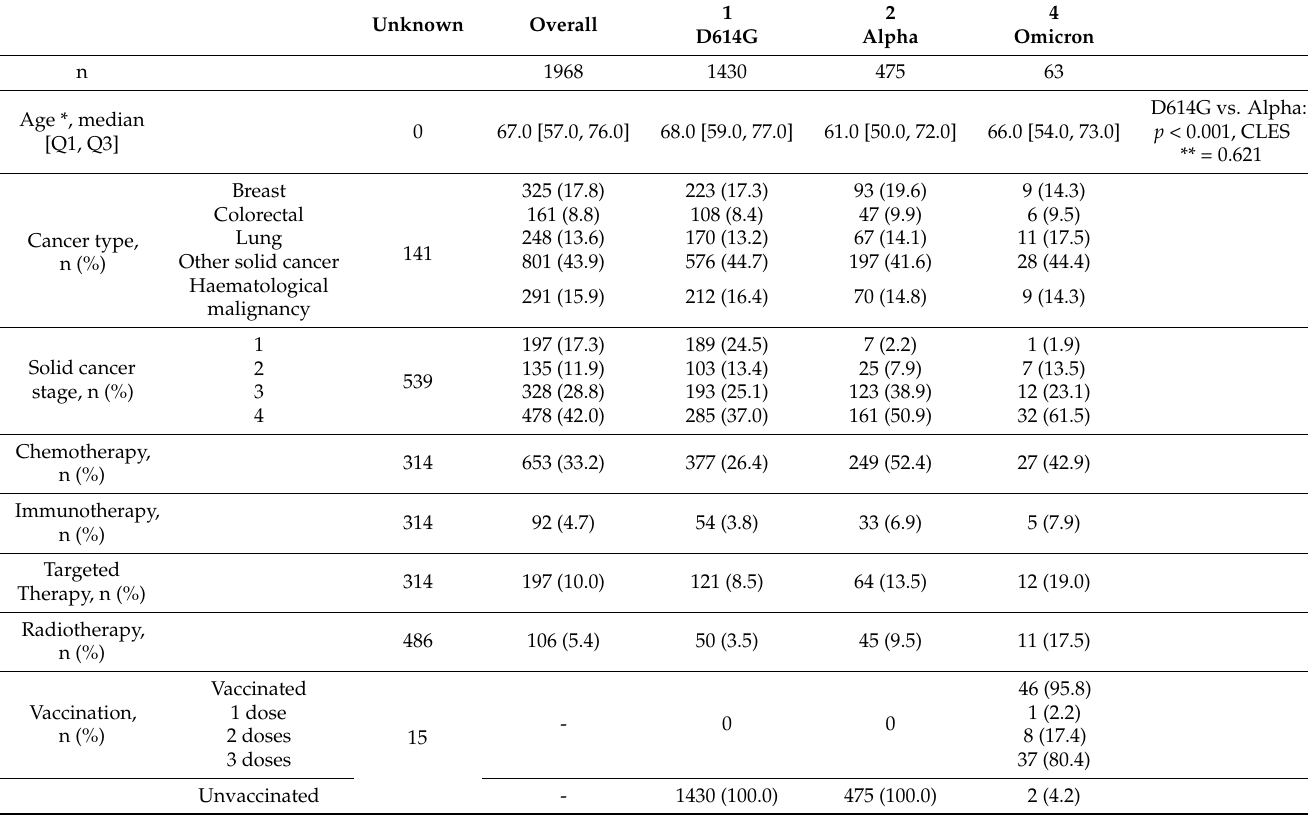
Table 1. Patient characteristics during three SARS-CoV-2